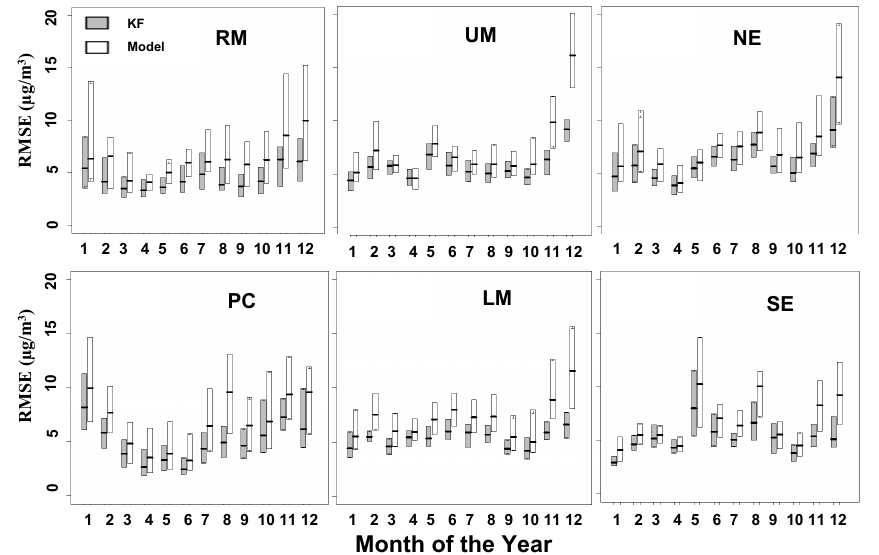
Fig. 7. Monthly box plots (only 25 th and 75 th percentiles and median values are shown) of RMSE values of the daily mean PM 2 . 5 concen- trations (µg/m 3 ) for the raw model forecasts and KF bias-adjusted forecasts for all the sub-regions.